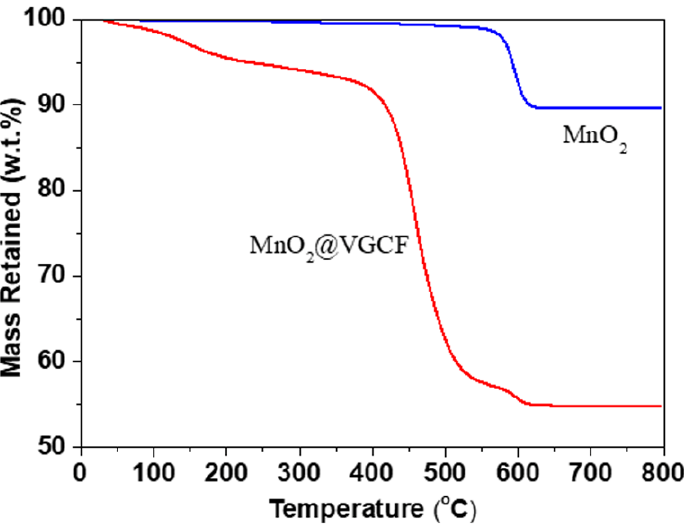
Figure 3. Thermogravimetric analysis of the MnO 2 and the MnO 2 @VGCF composites in air.